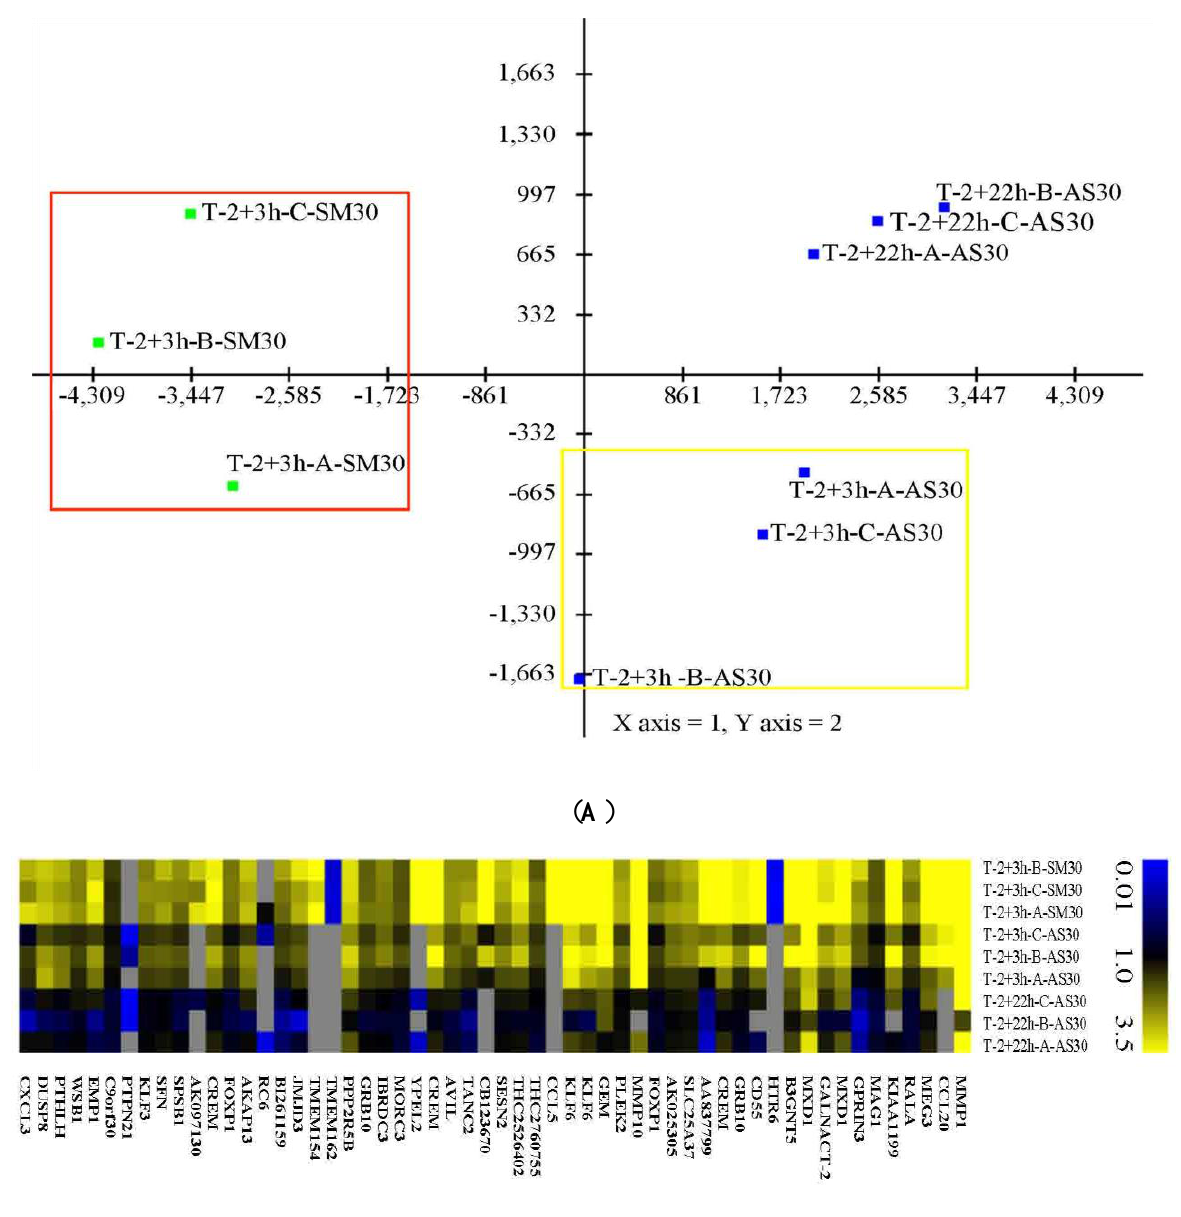
Figure 3. Microarray data analysis in A549 cells treated with SM30 and AS30 NPs. ( A ) Cell treatments and recovery times appear different from each other (green: SM30 NPs and blue: AS30 NPs). The red rectangle identifies the group of cells treated with smaller NPs (SM30) while the yellow one identifies the group of cells treated for the same time with bigger NPs (AS30). ( B ) Heat map of differentially expressed genes showing a decreased expression from SM30 treated cells to AS30 treated cells. Most of genes are involved in inflammatory response processes. T = Treated; 2 + 3 h and 2 + 22 h (2 h of treatment in serum-free medium containing 0.02 mg/mL NPs followed by 3 or 22 h of recovery time in complete medium). A, B, C indicates biological